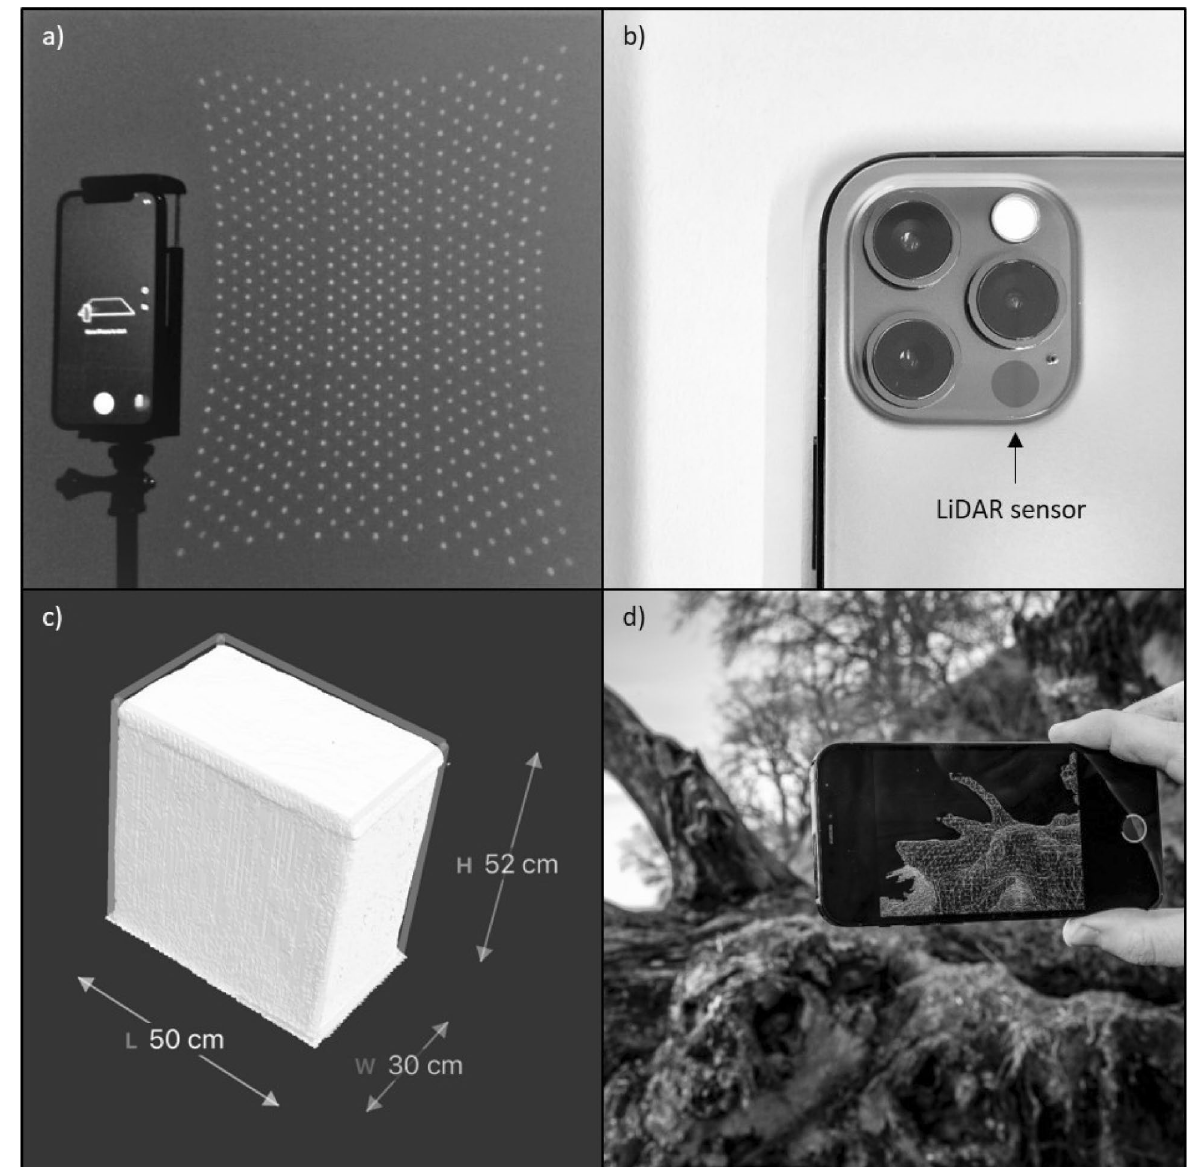
Figure 2. The Apple iPhone 12 Pro mounted on a selfie stick with the LiDAR sensor emitting an array of 8 × 8 points diffracted into 3 × 3 grids making a total of 576 points ( a ), Apple iPhone 12 Pro camera module ( b ), 3D model of an object with measured dimensions ( c ), 3d Scanner App scanning deadfall at Roneklint on the Apple iPhone 12 Pro (Photo credit Kent Pørksen) ( d To compare the iPhone LiDAR with smartphone photogrammetry, the same small area at the cliff of Roneklint was scanned again in September 2021: two times with the ‘3d Scanner App’, two photo sets were taken with the iPhone’s camera for SfM MVS models and two recordings were obtained with the ‘EveryPoint’ app (Supplemen- tary Fig. S18a-f). Out of the six models, one SfM MVS model was selected as a reference for M3C2 comparison to the remaining five models. The beach in front of the cliff was covered in dense vegetation. Both the SfM MVS and the ‘EveryPoint’ algorithm could not create points in the area with the vegetation. Therefore, the comparison focused on the bare soil at the cliff face. Since the areas closest to the iPhone are not considered in the distance calculation, the ‘EveryPoint’ point cloud in this investigation is entirely based on photos and not a combination of iPhone LiDAR and photos. The mean M3C2 distance between the two SfM MVS point clouds are the small- est and the distances between the ‘EveryPoint’ point clouds to the reference cloud are slightly larger than those between the ‘3d Scanner App’ point clouds and the reference cloud (Supplementary Table S3). Nevertheless, the standard deviation is slightly higher for the ‘3d Scanner App’ point clouds, compared to the ‘EveryPoint’ point clouds. The main difference between the point clouds however, is the areas that are not regarded in the photo- grammetry point clouds. Whereas the iPhone camera SfM MVS and the ‘EveryPoint’ photogrammetry approach